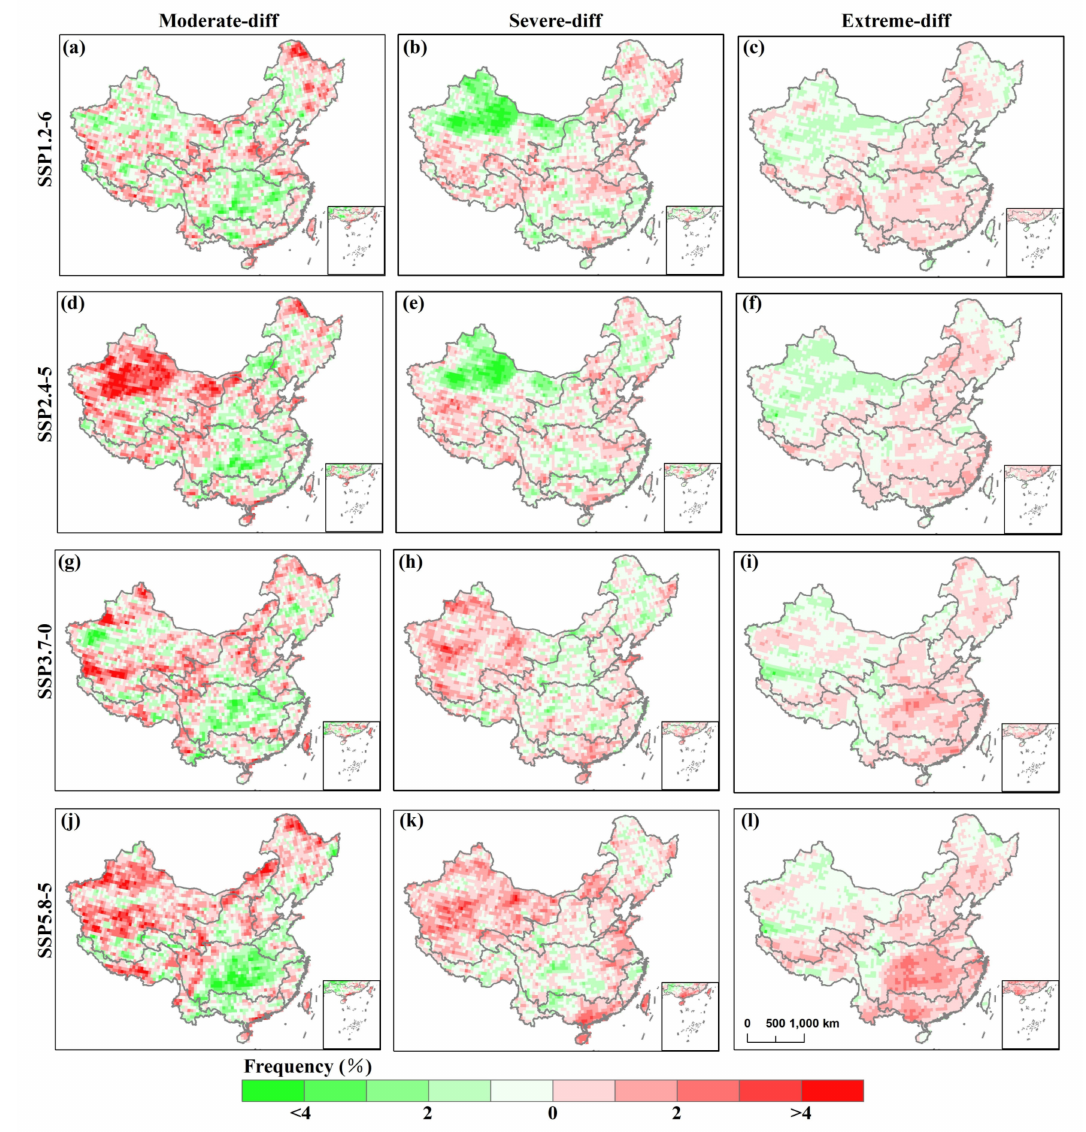
Figure 11. Comparison of the spatial pattern of the difference in the total frequency of ( a , d , g , j ) moderate drought, ( b , e , h , k ) severe drought, and ( c , f , i , l ) extreme drought across China under the ( a – c ) SSP1-2.6, ( d – f ) SSP2-4.5, ( g – i ) SSP3-7.0, and ( j – l ) SSP5-8.5 scenarios for the